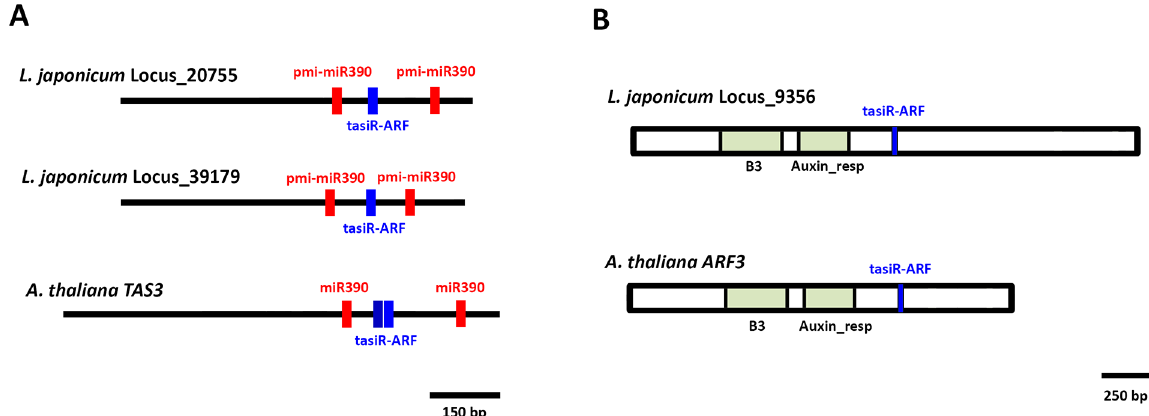
Fig 5. Trans-acting siRNA 3 targeting ARF transcripts in ferns. (A) Schematic representations of two L . japonicumTAS3 RNAs (Locus 20755 and 39179). Predicted sites targeted by pmi-miR390are indicatedin red. The regionpredicted to generatea tasiRNA targeting a mRNA encoding a ARF transcription factor is indicatedin blue. For comparison, a TAS3 transcript from A . thaliana (NR_143941.1) is also shown. (B) Schematic representation of a ARF mRNA (Locus 9356) from L . japonicum targeted by tasiRNA derived from TAS3 transcripts (blue stripe). The A . thalianaARF3 mRNA (At2g33860) is shown for comparison. Conservedprotein domainsencodedby the ARF mRNAs are indicated.